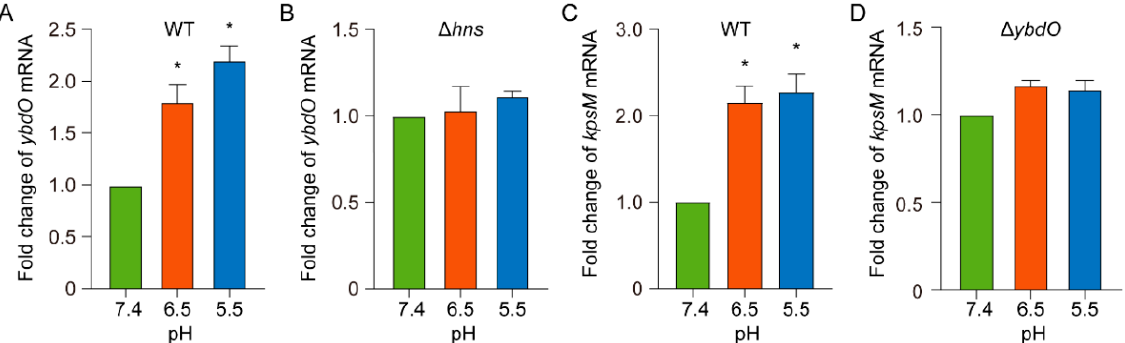
Figure 7. Acidic pH induces ybdO and kpsM expression. ( A , B ) Fold change in ybdO mRNA levels in the WT and Δ hns strains at various pH values. ( C , D ) Fold change in kpsM levels in the WT or Δ ybdO strains at various pH values. Data represent the means ± SD from three independent experiments and were analyzed using Student’s t -test. * p < 0.05.